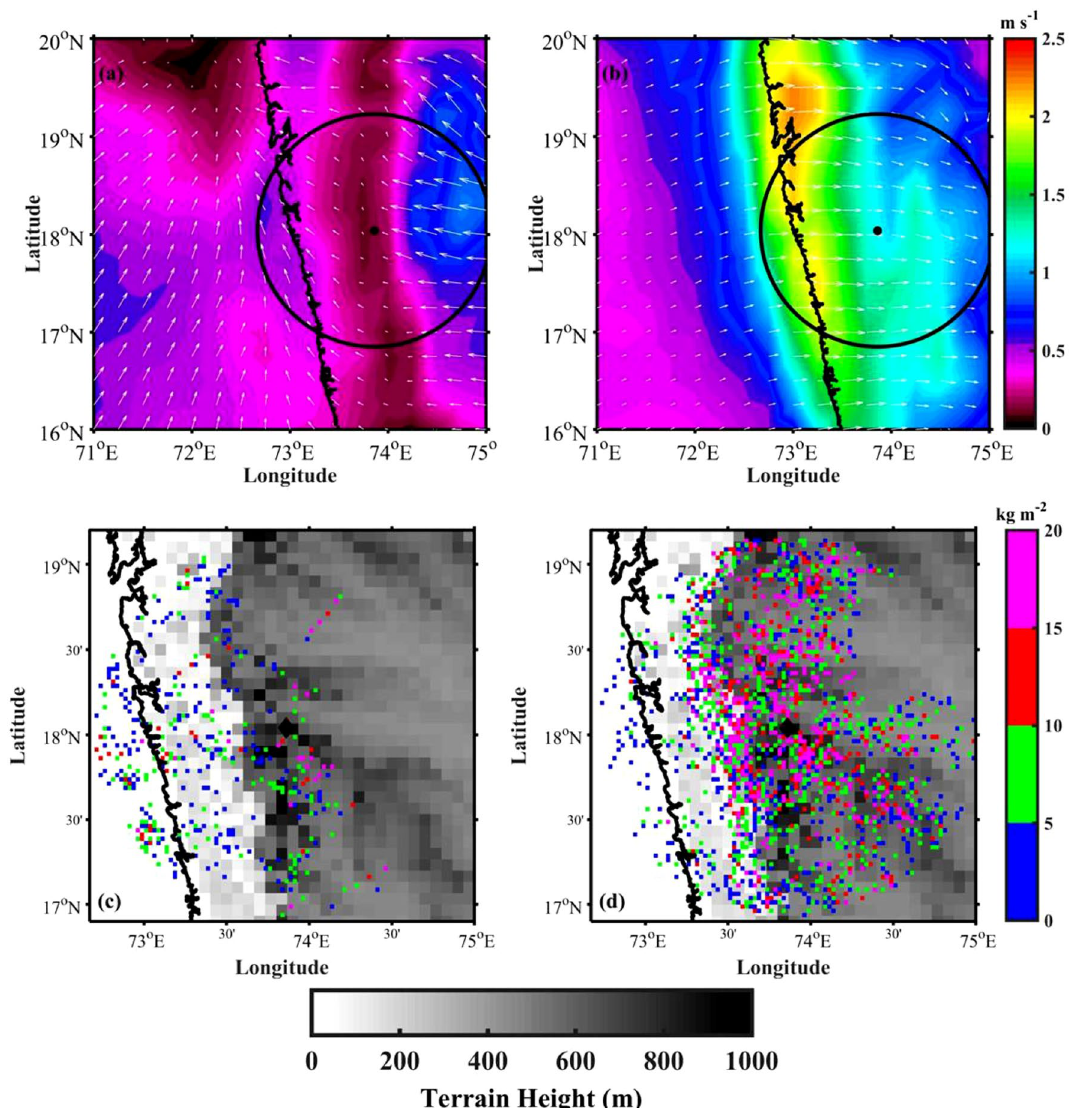
Figure 4. The wind speed (colour-filled contours) and wind vector differences ( a ) between 0230 and 2030 LT, ( b ) between 1430 and 0830 LT. The VIL difference between ( c ) 0000–0600 and 1800–2400 LT, ( d ) 1200–1800 and 0600–1200 LT. The radar domain topography is considered in ( c , d ) and shown with graycolor multiscale interactions between large-scale circulations and land-sea breeze that plays a vital role in the diurnal cycle of rainfall over the tropical islands. With increased solar radiation in the morning hours, the horizontal wind speed increases at the coastal and oceanic regions during 1130 LT (Fig. 5b). At this time, negative vertical velocity and convergence (Fig. 6b) can be found over coastal and upslope regions. This shows that the CSs are propagated eastward to coastal mountain regions by 1130 LT. At 1430 LT, the vertical motion deviations are negative over higher altitudes (Fig. 5c). The surface convergence (Fig. 6c) is also negative along the upslope regions and on the mountain peak, indicating further propagation of CSs towards the mountain peak by afternoon. With the maximum solar heating in the afternoon, the rising motion induced by the low-level convergence between the sea breeze front/seasonal winds and the mountain enhances. This indicates that the orographic response to the prevailing monsoon flow from the surrounding oceanic regions superimposed with the land-sea thermal contrast is responsible for the afternoon maximum in the CSs occurrence over high altitude regions in the WG. Romatschke and Houze 9 observed the afternoon maximum in the rainfall over the Indian west coast. The present analysis supports the mechanism hypothesized by Romatschke and Houze 9 in explaining the diurnal cycle of rainfall over the WG region. At 1730 LT, the negative vertical motion deviations (Fig. 5d) and convergence (Fig. 6d) can be observed along the coastal and leeside of the mountain, however, the magnitude is small. This may be due to the dissipation of CSs and further propagation to leeside by evening. It can be observed from Fig. 2c,d that the CSs developed during afternoon hours are deeper and more intense than those developed in the nighttime. What are the underlying physical processes that are responsible for the